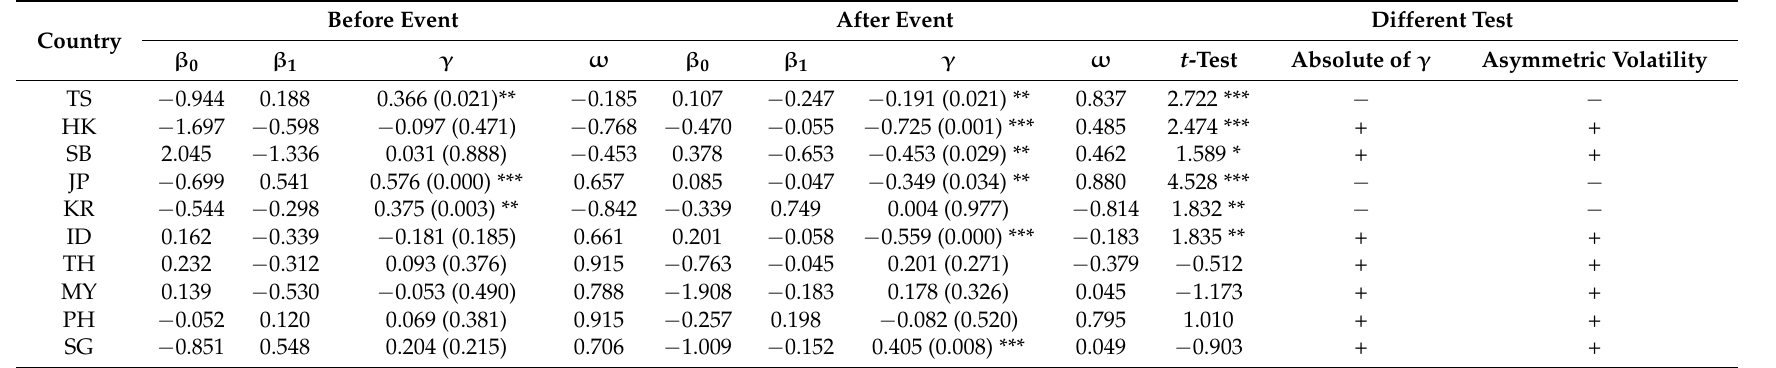
Table 14. The EGARCH model results: Hurricane Katrina.